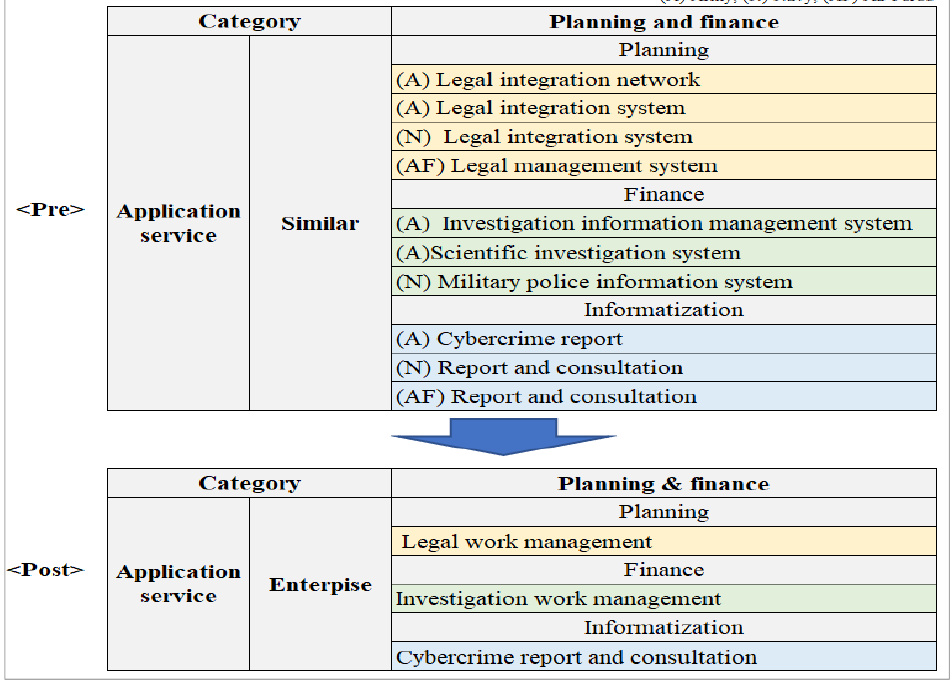
Figure 11. Integrating similar services into new enterprise service .